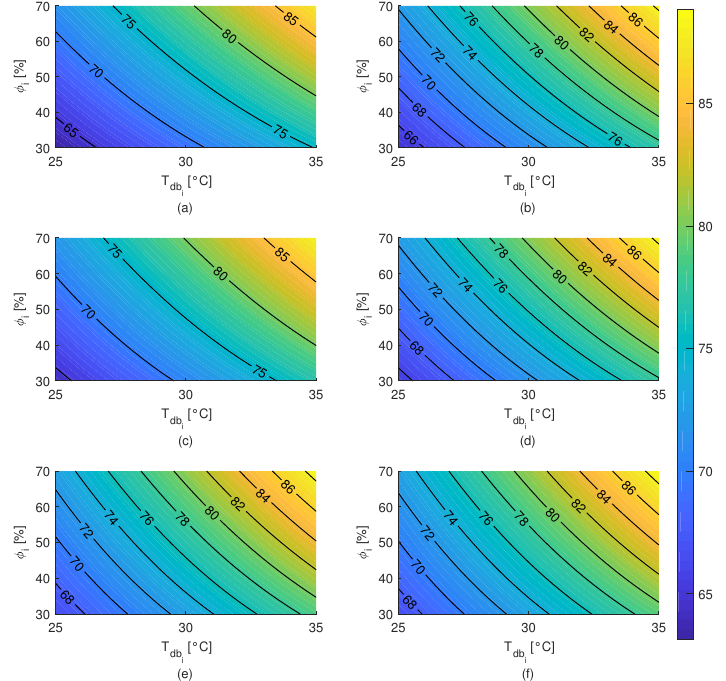
Figure A6. Temperature–Humidity Index at outlet par air conditions as a function of dry-bulb temper- ature of inlet air ( T db ) and relative humidity ( φ i ) for the pad studied. ( a ) Cellulose. ( b ) Small coconut i shell (7.9–12.7 mm). ( c ) Big coconut shell (12.7–19.0 mm). ( d ) Burnt-clay bricks (12.7–19.0 mm). ( e ) Small pumice stones (34.9–45.0 mm). ( f ) Big pumice stones (45.0–55.5